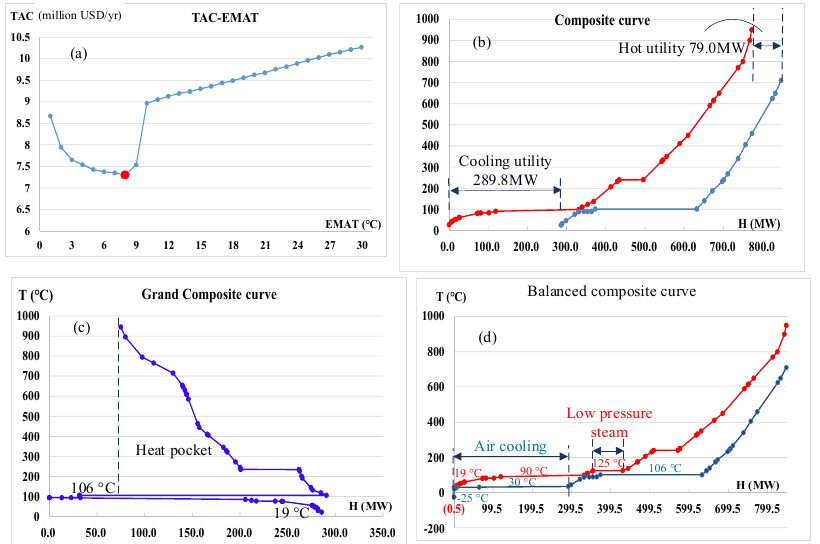
Figure 8. ( a ) TAC vs. ∆ T min , ( b ) cold and hot composite curves, ( c ) grand composite curve, and ( d ) balanced composite curve of the system. (Note: in figures ( b , d ), red line represents hot compound curve; blue line represents cold compound curve.)